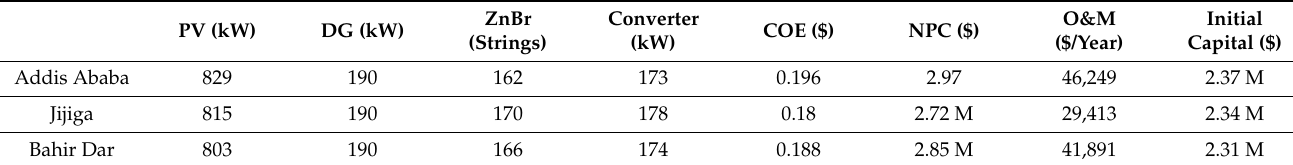
Table 4. Optimal values of the PV/DG/ZnBr system.